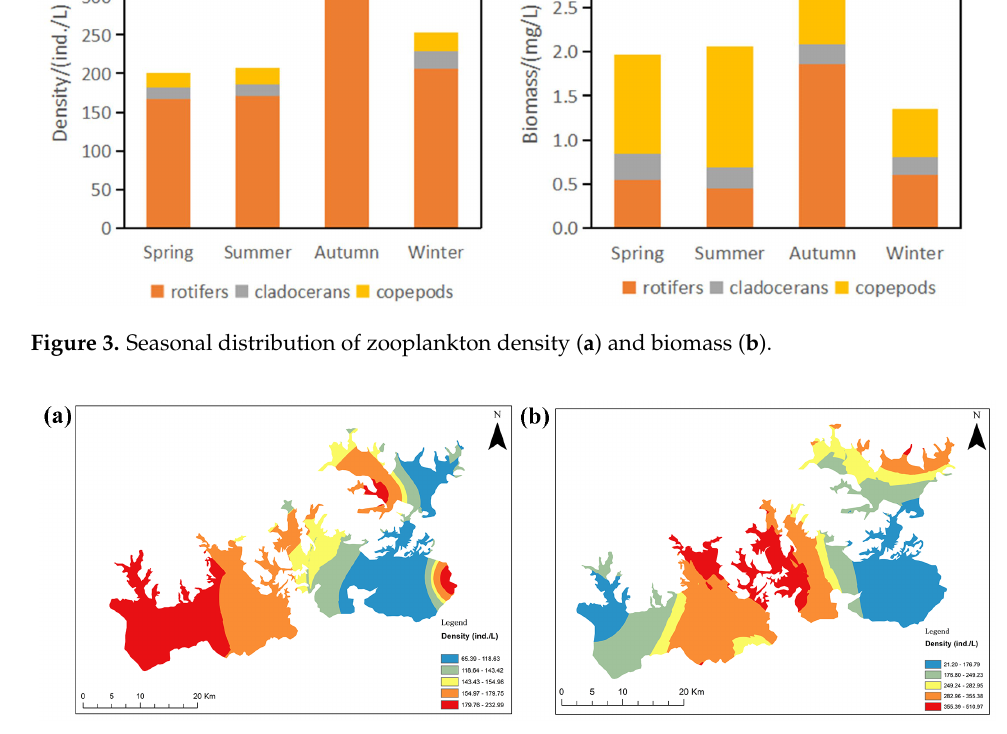
Figure 3. Seasonal distribution of zooplankton density ( a ) and biomass ( b ).